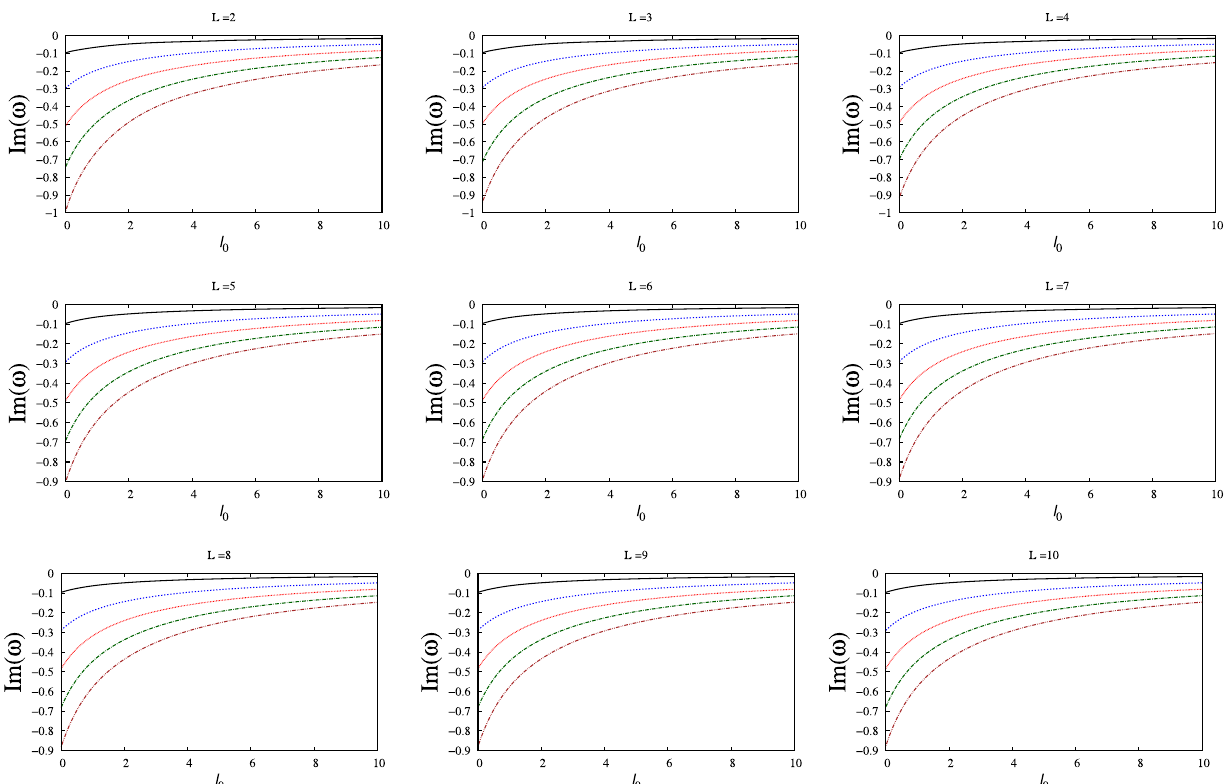
Fig. 5 Imaginary part of the QNM for Model 4 as a function of the hair α for different values of L and n . Each plot corresponds to a different value of L . The values for n are 0 (black line), 1 (blue line), 2 (red line), 3 (green line), 4 (brown line) Table 1 Numerical values for Model Re (ω) and Im (ω) for α = 1